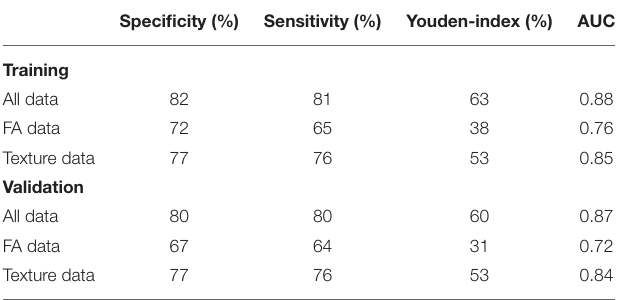
TABLE 2 | Sensitivity and specificity of the linear support vector classifier.